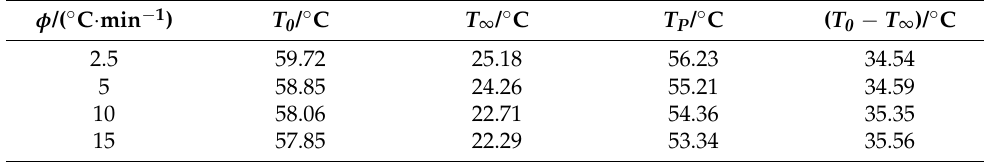
Table 9. The non-isothermal crystallization parameters in the presence of 100 ppm AMAC.